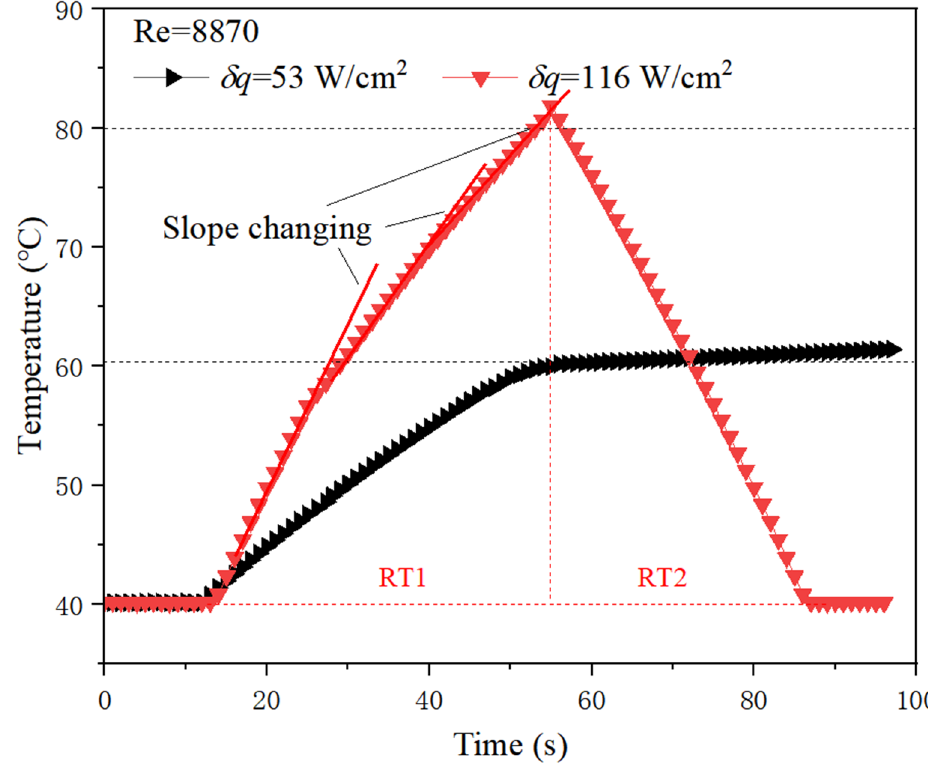
Figure 10. Temperature response characteristics to different heating power.